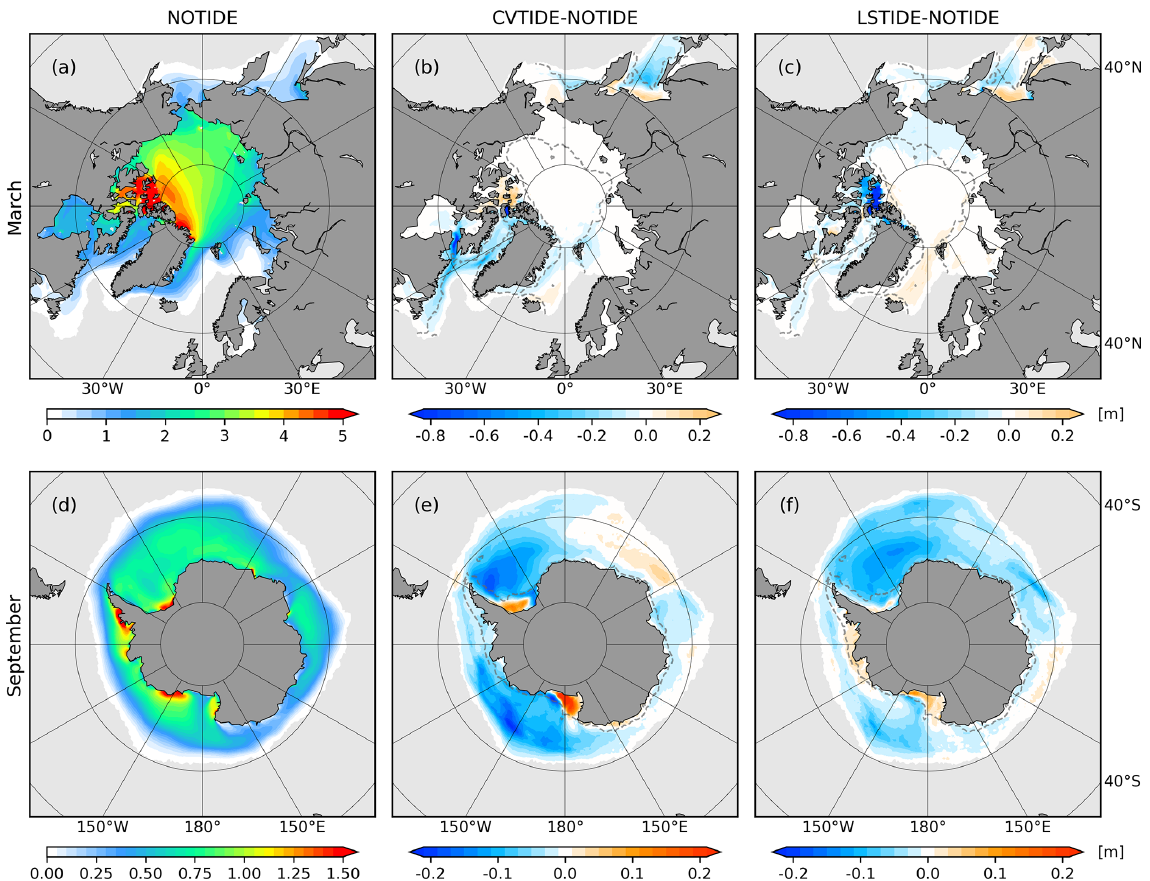
Figure 5. Polar sea ice thickness in the three sensitivity runs. Panels (a) and (d) show the results from the control run, and the other panels show the differences. Panels (a) – (c) and (d) – (f) show the Arctic (March) and Antarctic (September) results. The grey backgrounds mask the ice-free areas, and the dashed grey line represents the 500/1000m isobath for panels (a) – (c) / (d) – (f) .